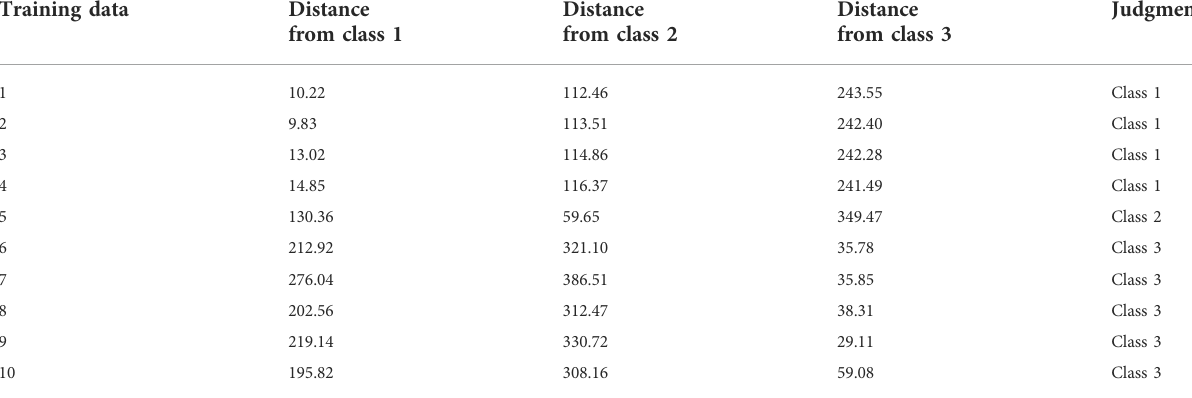
TABLE 5 Distance table between training samples and cluster